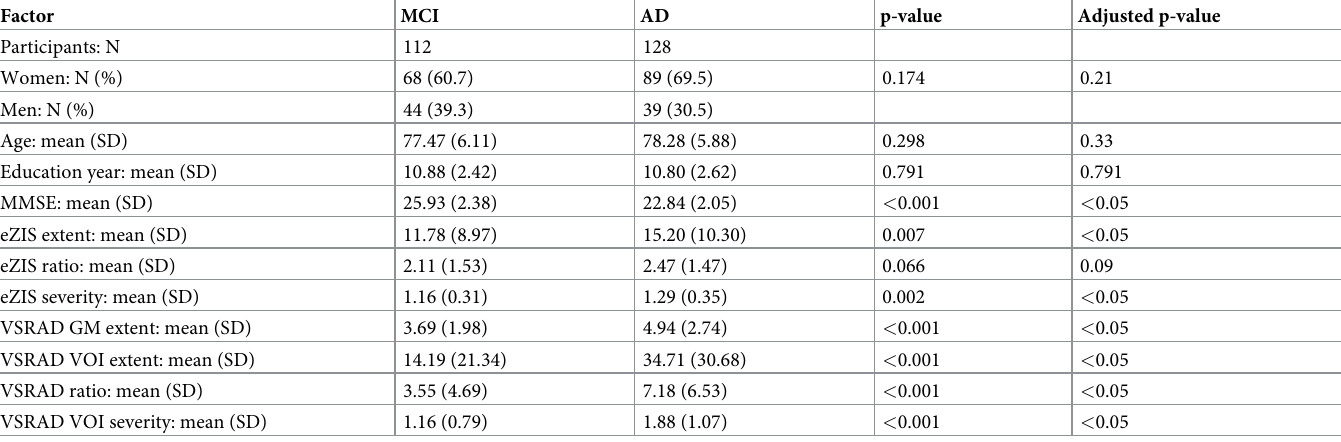
Table 1. Demographic and clinical data for participants.